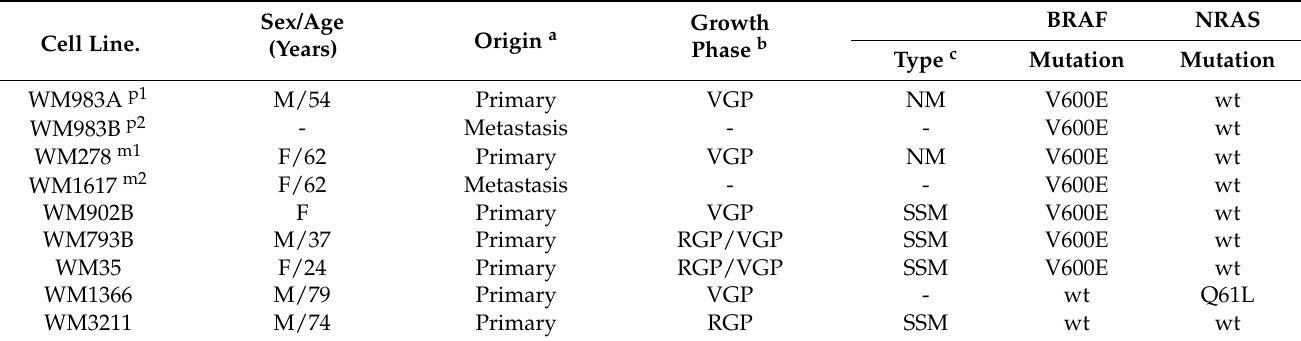
Table 1. Characteristics of human melanoma cell